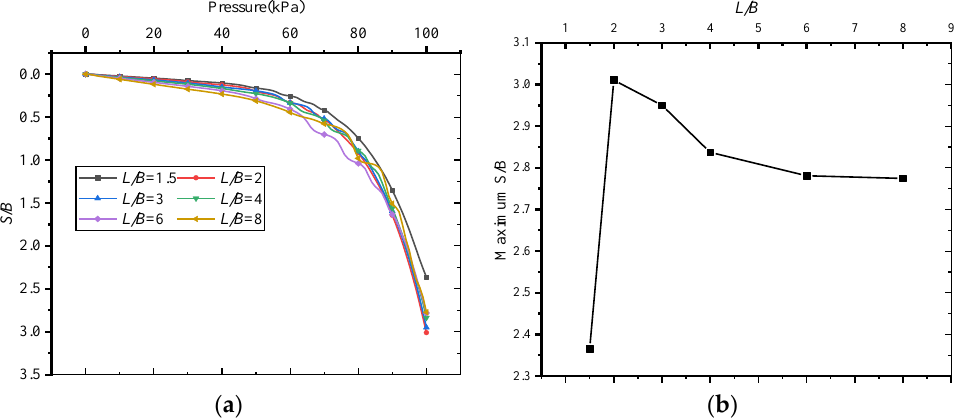
Figure 18. ( a ) Comparison between pressure and S/B and ( b ) Maximum S/B comparison under dif-